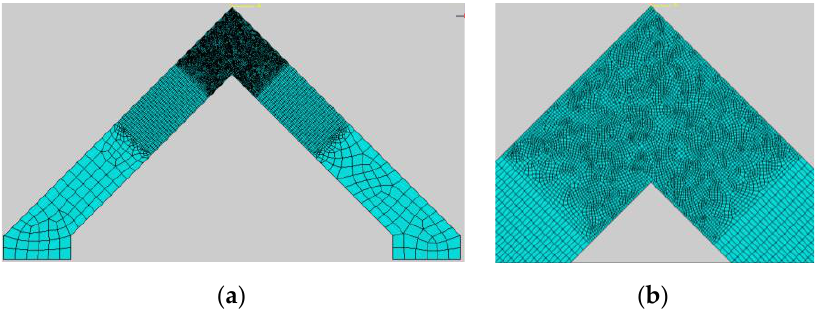
Figure 32. Meshing of modeled RV9 specimen ( a ) with zoomed corner zone ( b ).